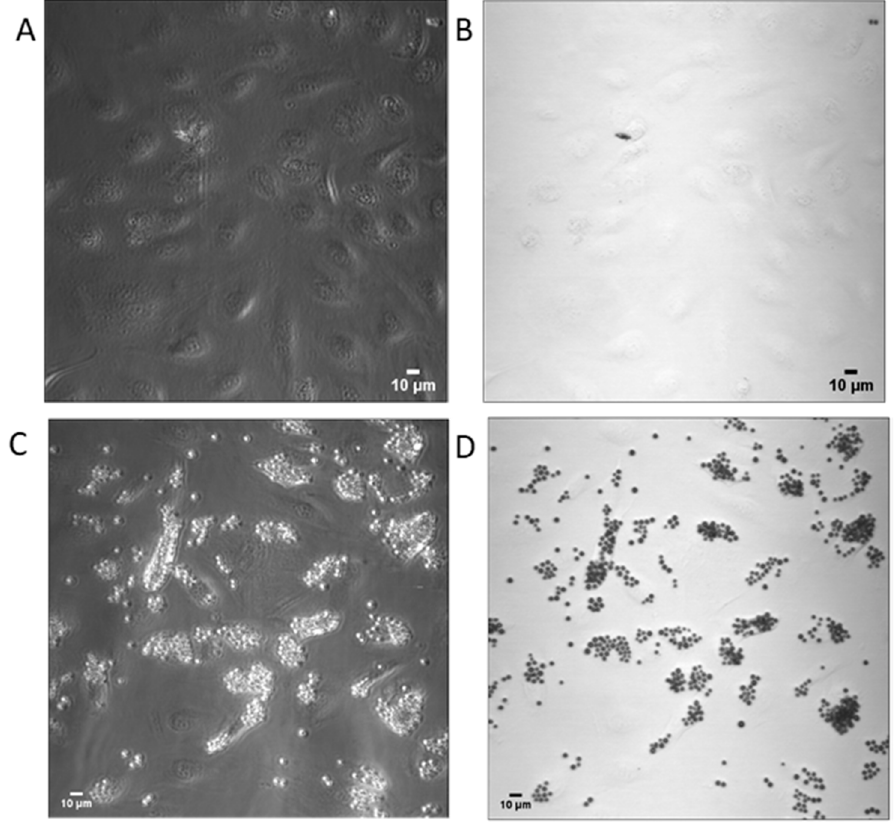
Figure 5. Optical microscopy images (long distance objective 40×) of targeted PVA-cRGD MBs’ adhesion on HUVEC cells in a dynamic flow at 37 °C post-fluxing (10 min), inversion (5 min), and washing with PBS (10 min), in comparison with plain MBs: ( A , B ) cell interaction with plain PVA MBs (control) in phase contrast and bright field, respectively; ( C , D ) cell interaction with PVA-cRGD MBs and phase contrast and bright field, respectively.